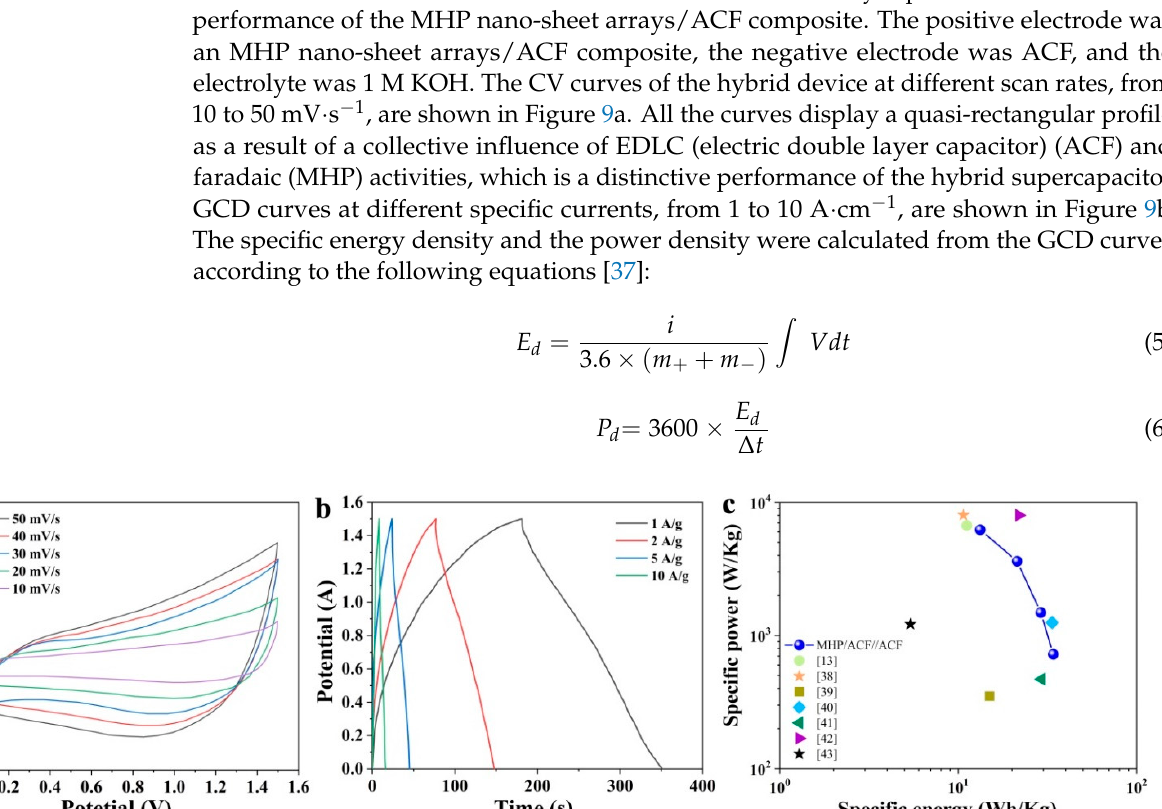
Figure 8. ( a ) Stress-strain curves of the MHP nano-sheet arrays/ACF composite (the inset figure is the digital image of bended sample); ( b ) CV curves of MHP nano-sheet arrays/ACF composite elec- trode before and after stretching.